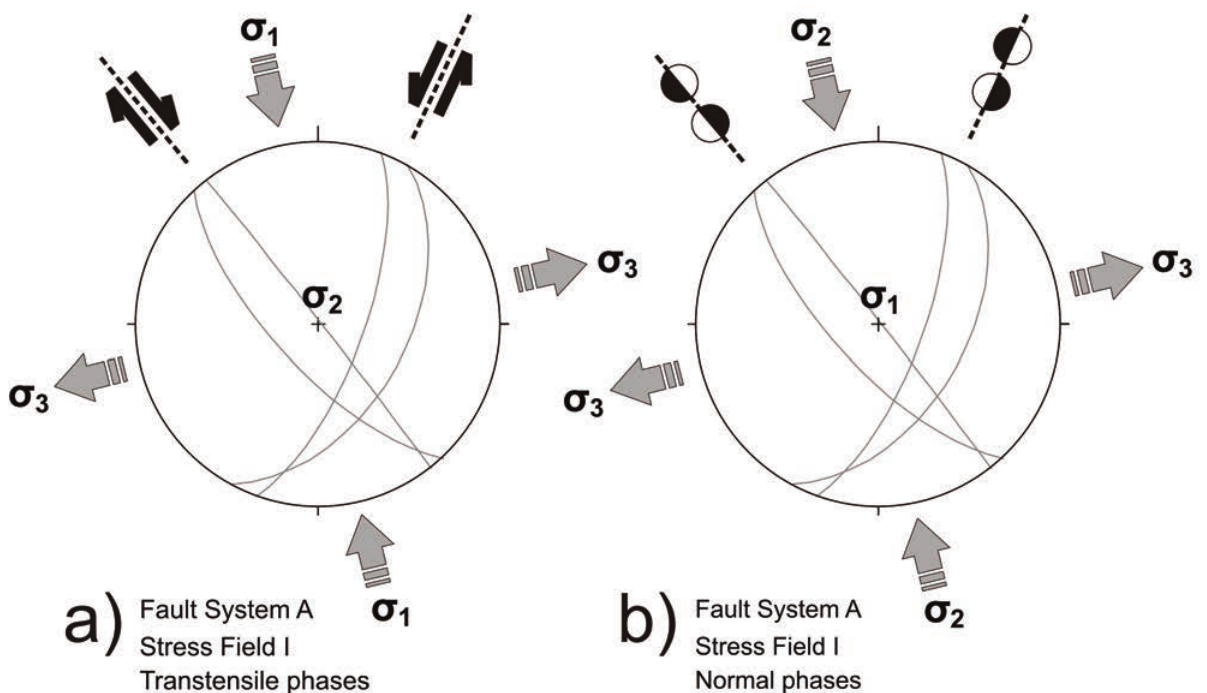
Figure 14. Stereographic projection of the stress field #1 deduced from structures of fault system A that have kinematic data of both slip components (lower hemisphere; Schmidt net – β diagram). a) transtensile stress field: NW-SE to NNW-SSE faults with dominant dextral slip component, conjugate of NNE-SSW to NE-SW structures with dominant left-lateral slip component. Horizontal NNW-SSE σ 1, horizontal ENE-WSW σ 3 and vertical σ 2; b) tensile stress field after permutation between σ 1 and σ 2: NW-SE to NNW-SSE faults, dipping to both sides, with dominant normal slip component conjugate of NNE-SSW to NE-SW faults, dipping to both sides, with dominant normal slip com- ponent. Vertical σ 1, horizontal ENE-WSW σ 3 and horizontal NNW-SSE σ 2. TectonicsFP software® [Ortner et al. 2002].